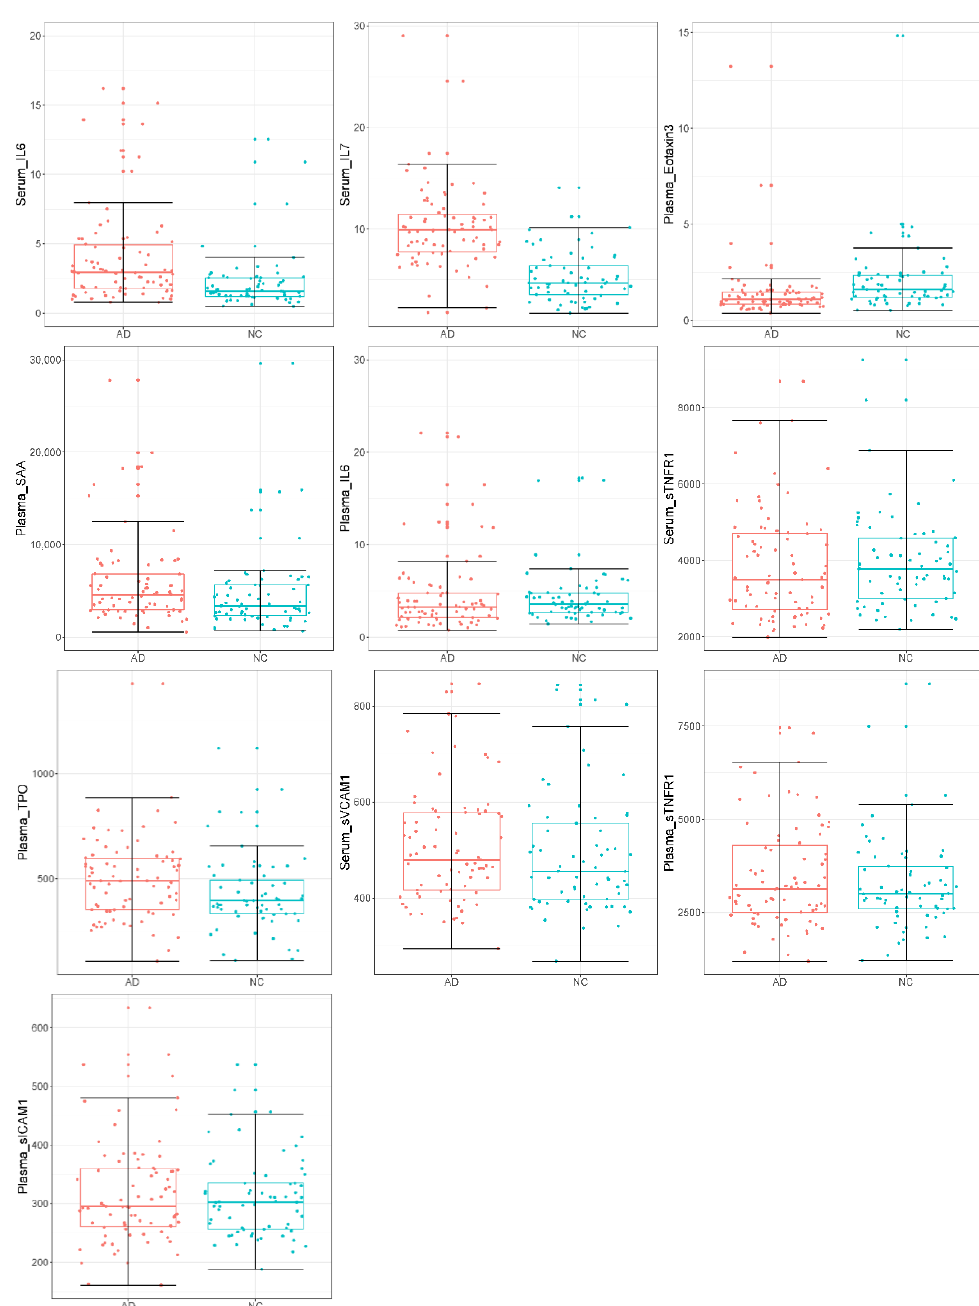
Figure 1. Boxplots for the selected 4 serum and 6 plasma biomarkers between 79 ADs and 65 NCs (red for ADs; cyan for NCs).